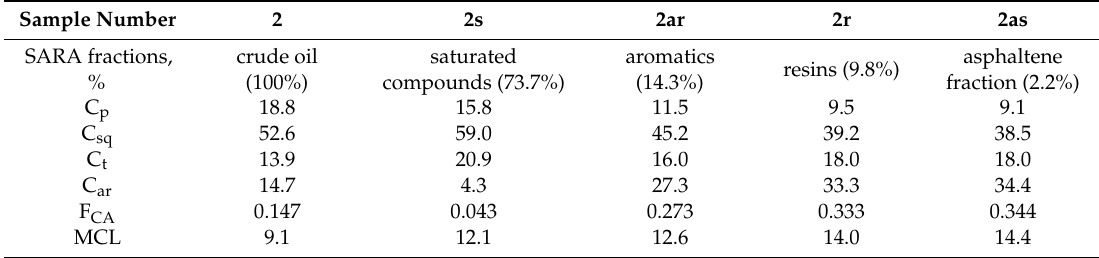
Figure 3. 13 C (175 MHz) NMR spectra of oil samples 2s–2as (s—saturated compounds, ar—aromatics, r—resins, as—asphaltene fraction). Table 6. Molar fractions (%) of primary (C p ), secondary and quaternary (C sq ), tertiary (C t ), aromatic (C ar ) groups, aromaticity factor (F CA ), and mean chain length (MCL) of aliphatic hydrocarbons based on 13 C NMR spectra of samples 2, 2s–2as.